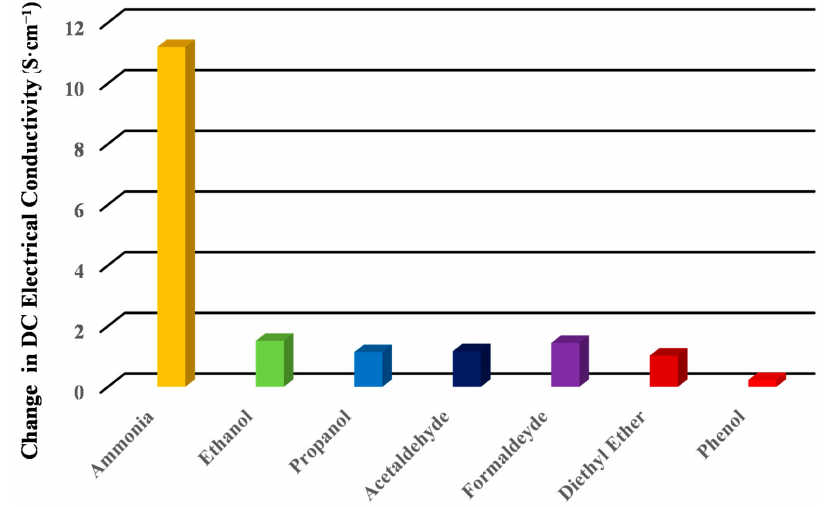
Figure 9. Selectivity of PPy / MoS 2 nanocomposite toward 1000 ppm of ammonia against di ff erent 1 M